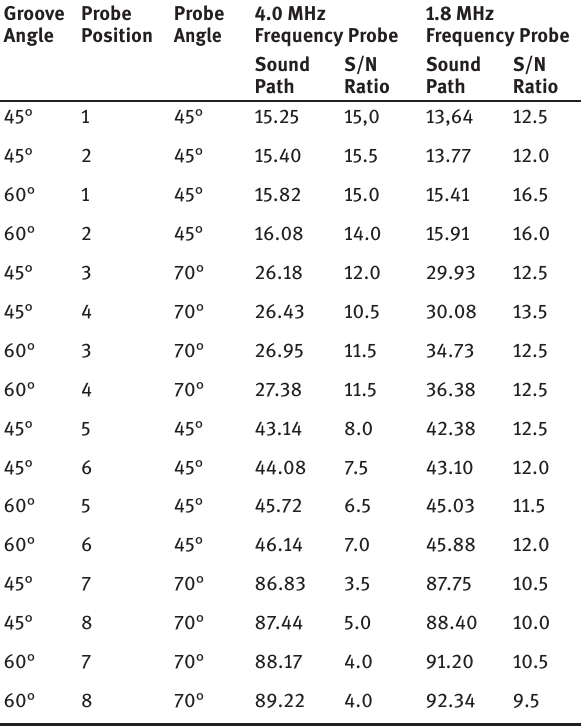
Table 4: Results of Ultrasonic Tests using Transversal Longitudinal Probes. Groove Angle